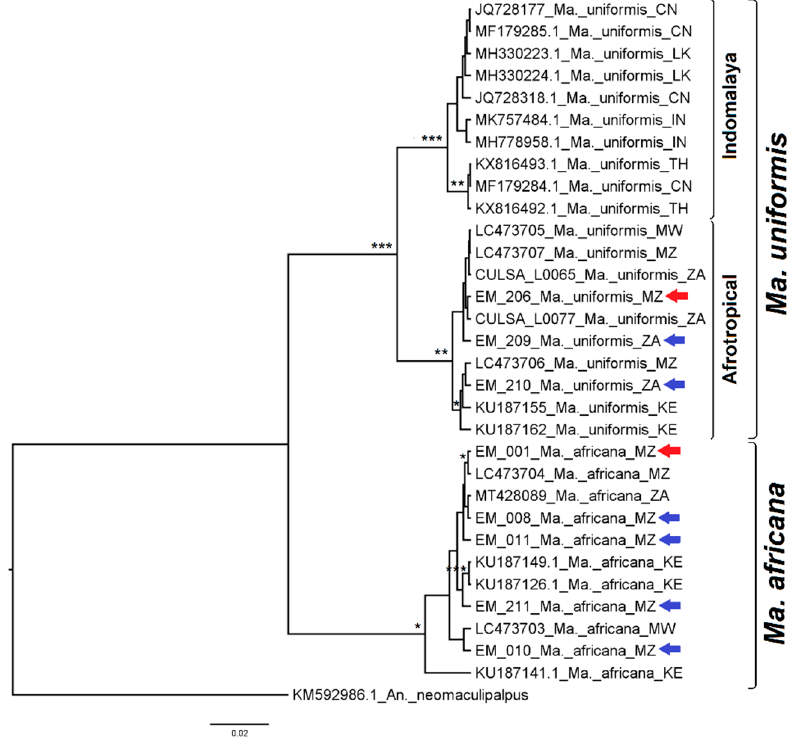
Figure 17. Phylogenetic analysis of 31 partial coxI nucleotide sequences from mosquitoes of the genus Mansonia. At specific branches, the number of * indicates the tree topological support revealed by the different phylogenetic reconstruction methods, assuming relevant bootstrap and aLRT values above 75% and posterior probability values above 0.80. The sequences obtained in this work are indicated by the “EM” code and those with associated genitalia are indicated by horizontal arrows (blue = males, red = females). The sequences downloaded from GenBank and Boldsystems are indicated by their respective accession numbers and access codes (respectively). Their country of origin [South Africa (ZA), China (CN), India (IN), Malawi (MW), Mozambique (MZ), Kenya (KE), Sri Lanka (LK), Thailand (TH)] are also indicated.